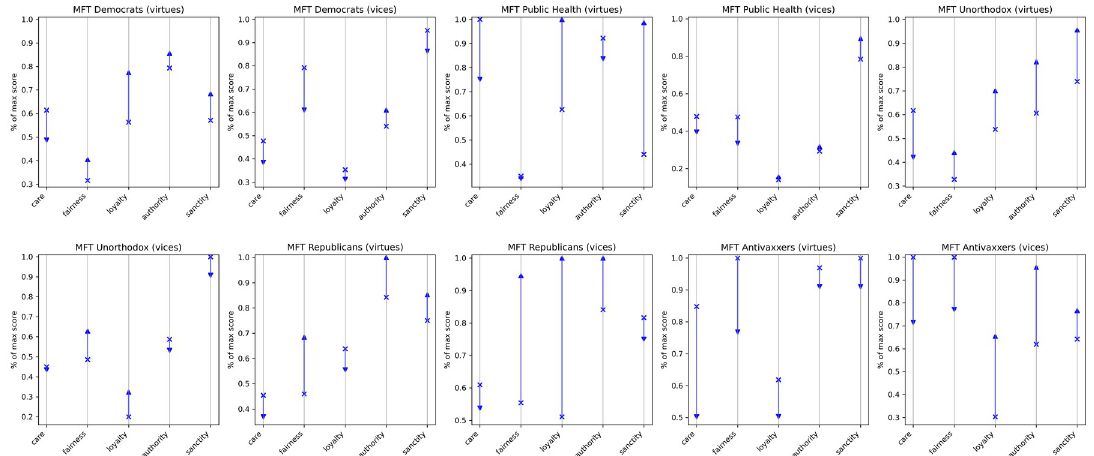
Fig 6. Changes in score for moral foundations dictionaries pre- and post-declaration. Components on X axis absolute score changes. Y axis shows percentage of max pre/post score across all groups (for raw scores, see SM §2.2). Arrow shows direction of change.